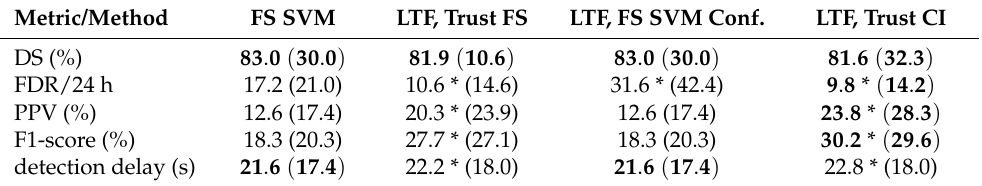
Table 3. Mean (standard deviation) performances of: FS SVM; LTF with the confidences of this SVM (FS SVM conf.); and LTF with trust models trained on CI (trust CI) and FS (trust FS) labels. A statistically significant improvement or degradation in performance compared to the original SVM is denoted by a star. The best result (or not significantly different from the best result) is shown in bold.